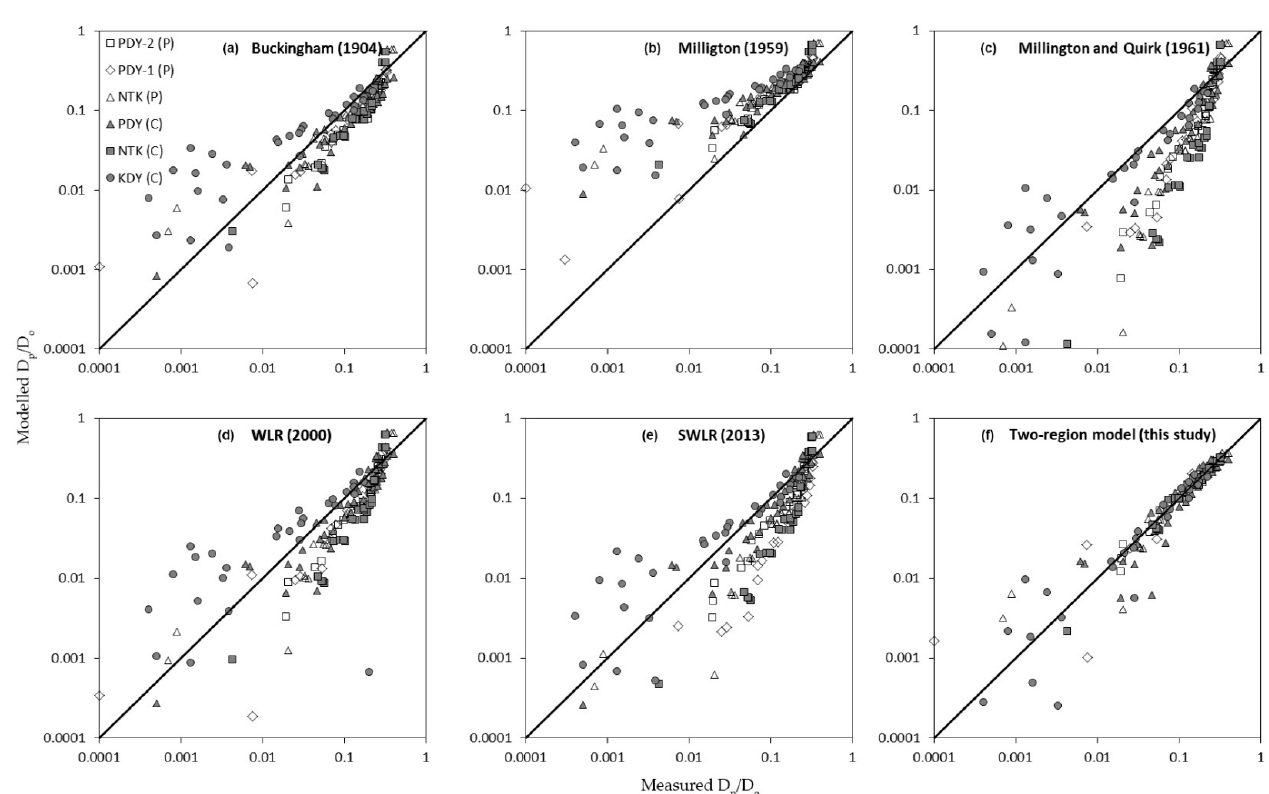
Figure 04 Figure 4. Scatterplot showing the measured and modeled D p /D o for repacked soils, using six predictive-descriptive models ( a – f ). PDY; Peradeniya (Sri Lanka), NTK; Nishi-Tokyo (Japan), KDY; Kandy (Sri Lanka). P and C in parentheses denote Pasture and Cultivated,